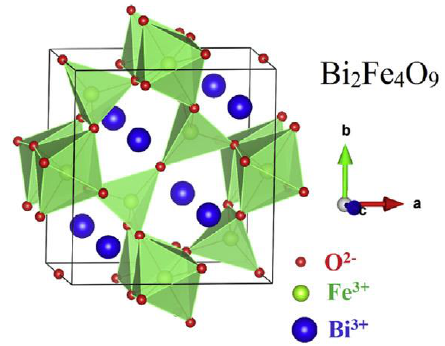
Figure 23. Cell unit of Bi 2 Fe 4 O 9 [80].